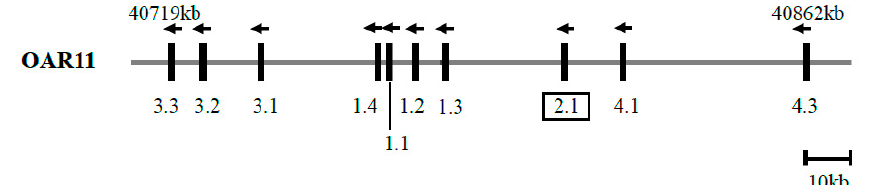
Figure 1. The location of the keratin-associated protein 2-1 gene on ovine chromosome 11. The newly identified keratin-associated protein 2-1 gene is boxed, and nine previously identified keratin-associated protein genes located nearby are also shown. A vertical bar indicates a keratin-associated protein gene, the arrow above the bar represents the direction of transcription, and the number below the bar represents the specific keratin-associated protein gene identity (e.g., 2.1 represents the keratin-associated protein 2-1 gene). The nucleotide coordinates refer to the Ovine Genome Assembly version 4.0, and are only approximate.